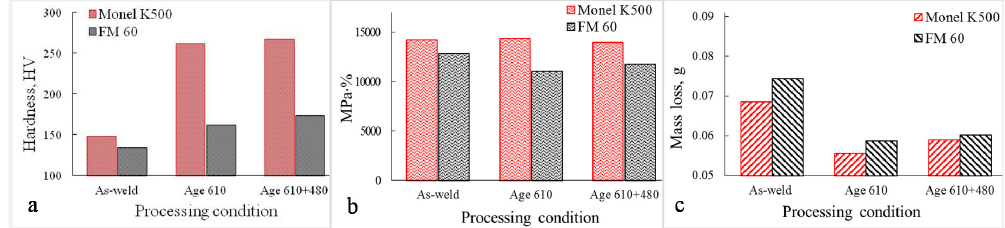
Figure 12. The variation in the mechanical properties, ( a ) hardness, ( b ) toughness and ( c ) wear resistance (mass loss), of Monel K500 (red) and FM60 (black) with heat treatment (500 mm/min deposition